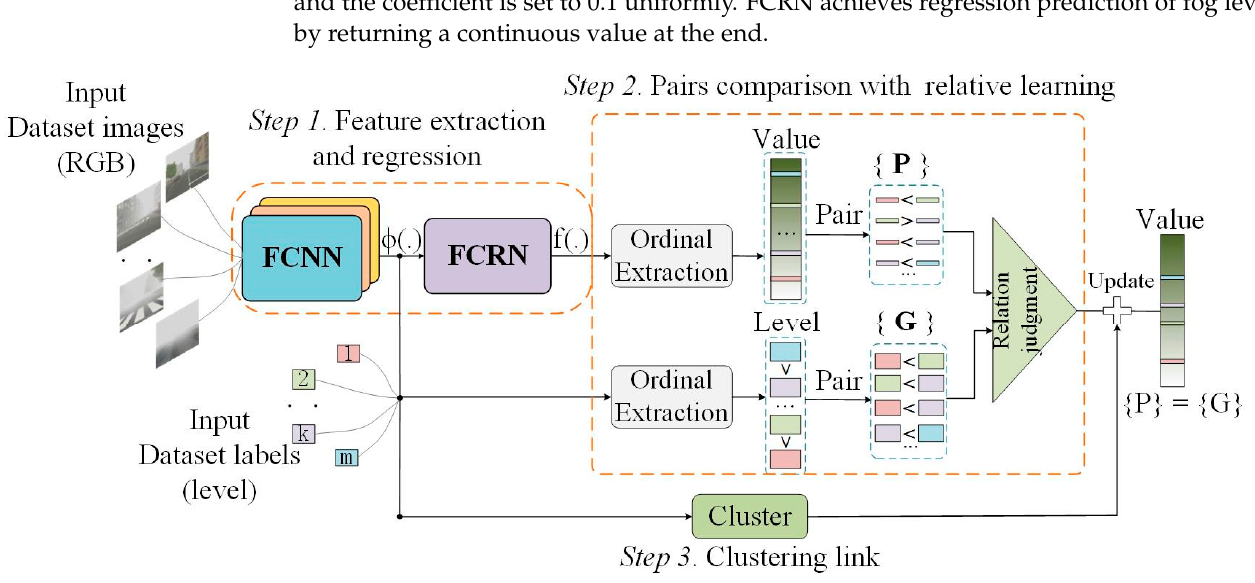
Figure 2. Schematic diagram of the proposed VISOR-NET with batch images.